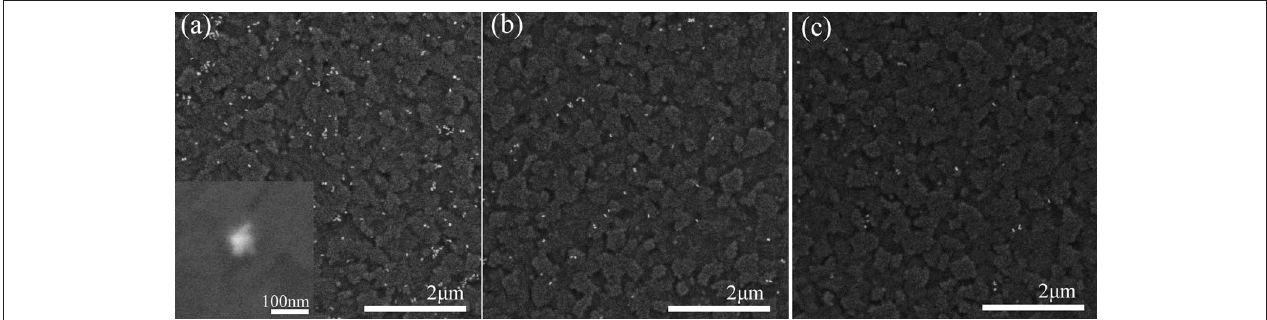
FIGURE 4 | SEM images of the PEDOT:PSS films with different Au NS volume ratio of (a) 2.0%, (b) 0.5%, and (c) 0.125%. The white dots are Au NSs. Inserted image (a) correspond to high magnification SEM image of Au nanostar.